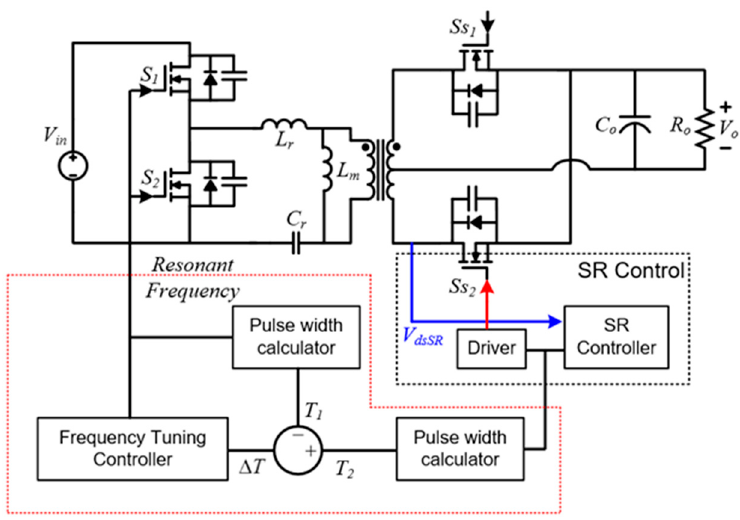
Figure 8. Control scheme of the resonant frequency tracking method shown in [31].